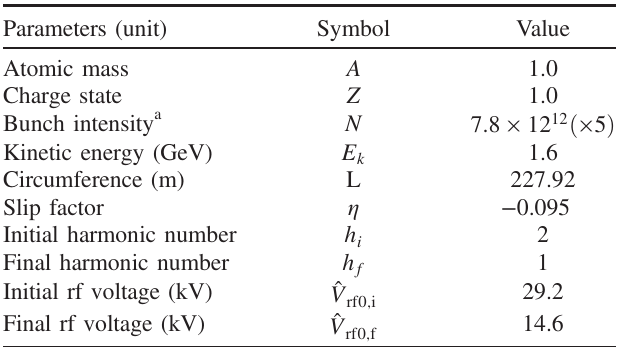
TABLE II. Basic parameters in the example simulation of bunch merging in CSNS-II/RCS.